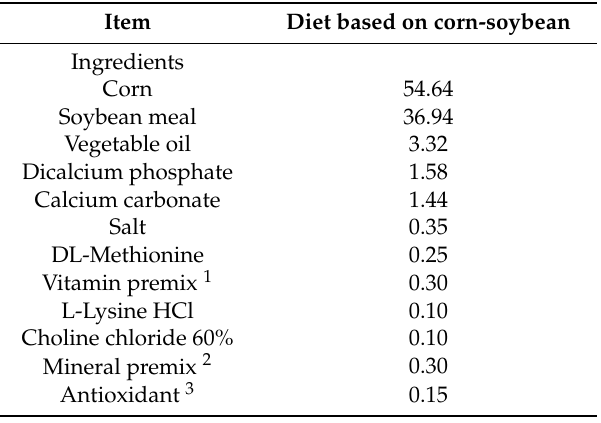
Table 1. Ingredients (%). Diet based on corn-soybean for broiler